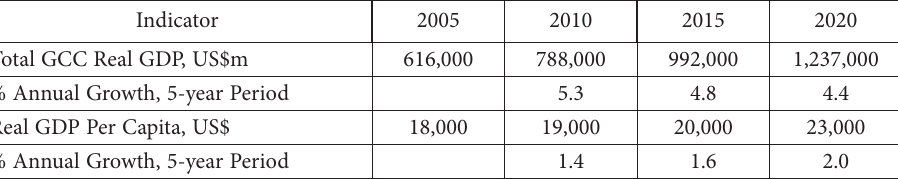
Table 6. The Core scenario projections of GCC long-term economic growth (source: EIU long-term forecasts, The Economist Intelligence Unit (2018) available at: